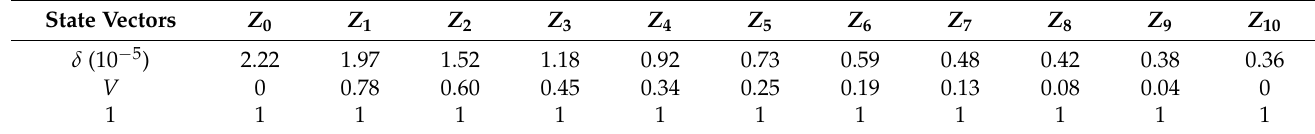
Table 1. The values of state vectors.